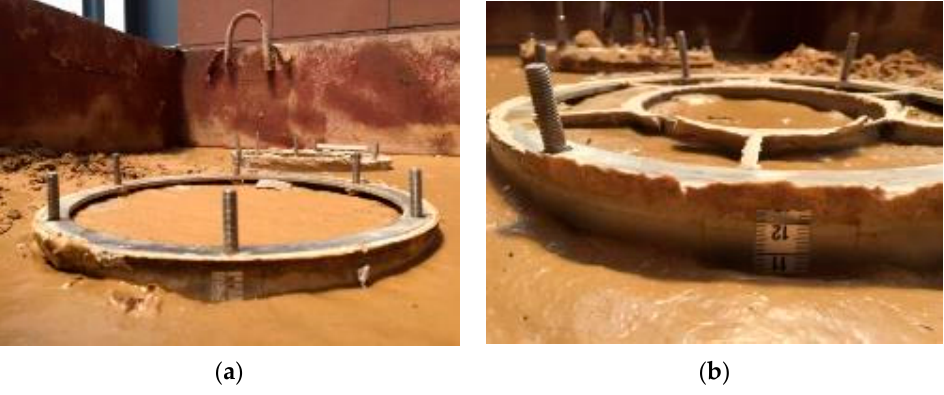
Figure 10. Soil plug in the penetration of the bucket foundation. ( a ) Mono-compartment bucket foundation; ( b ) Multi-compartment bucket